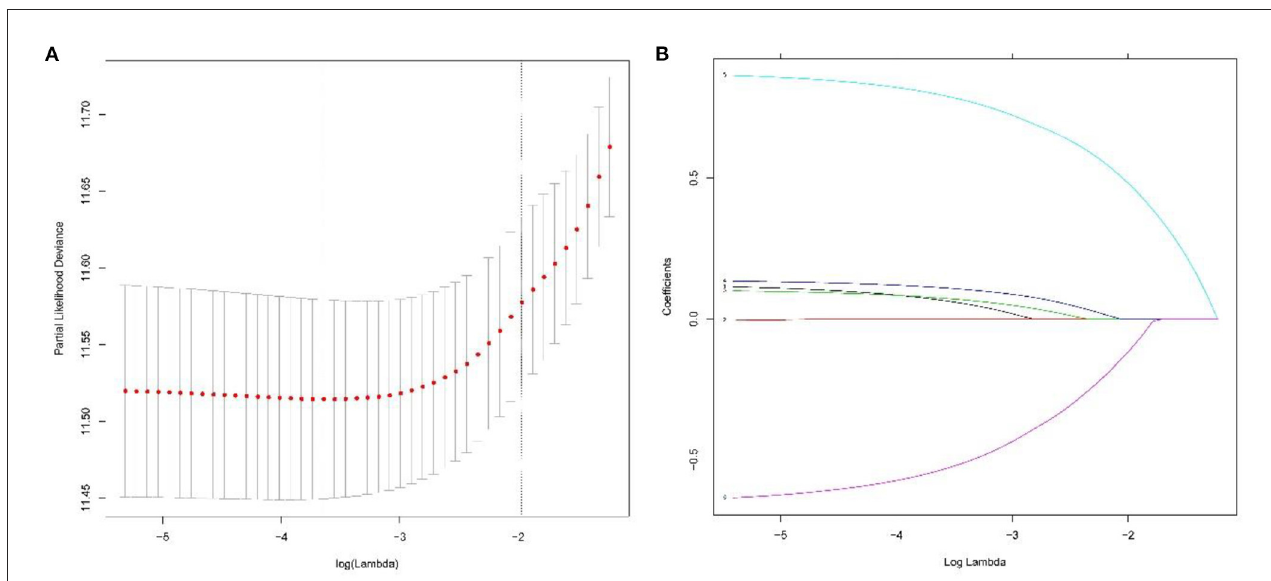
FIGURE2 To further narrow the range of variables involved in the regression analysis, the parameters were adjusted by 10-fold cross-validation, and established using the least absolute shrinkage and selection operator (LASSO) in the Cox model in the training set (A) . Combining the distribution of LASSO coefficients for six variables (tumor primary site, grade, tumor size, T stage, M stage, and chemotherapy) in cholangiocarcinoma patients, an optimal lambda filter was used to generate five variables (tumor primary site, tumor size, T stage, M stage, and chemotherapy) with non-zero coefficients (B) .